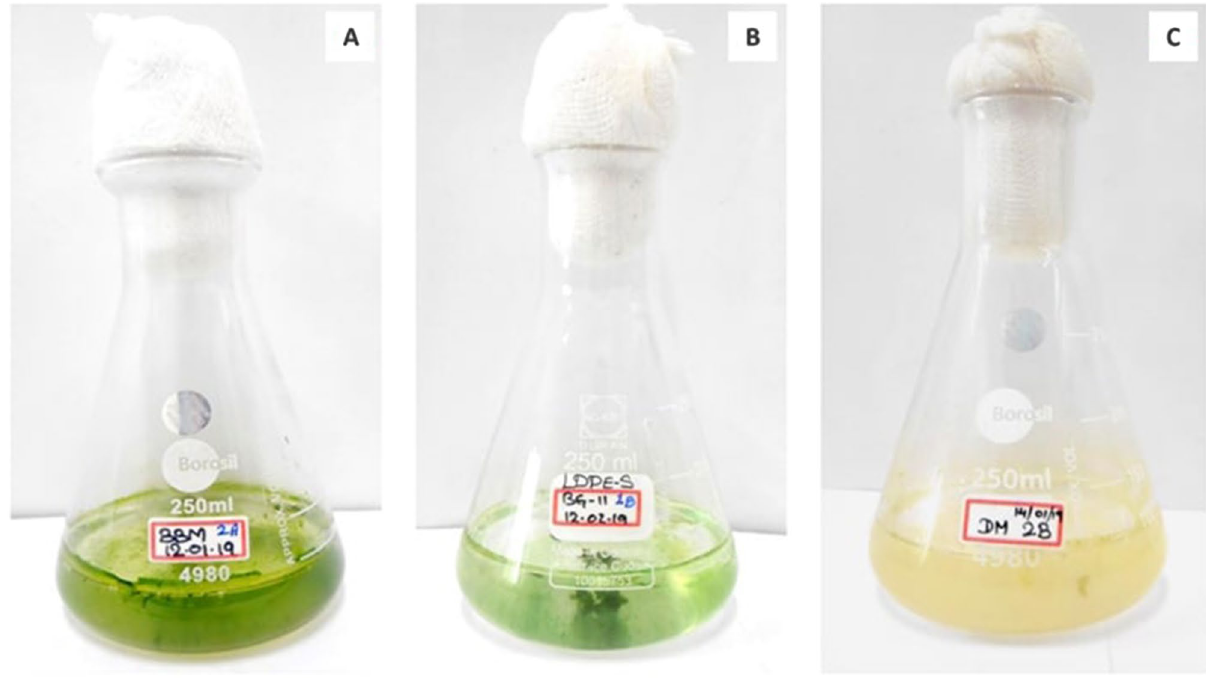
Figure 4. The three conical flasks showing different culture medium to target different microalgae colonize on LDPE sheet, ( A ) BBM culture medium for Chlorophyceae; ( B ) BG-11 for Cyanophyceae and ( C ) DM for